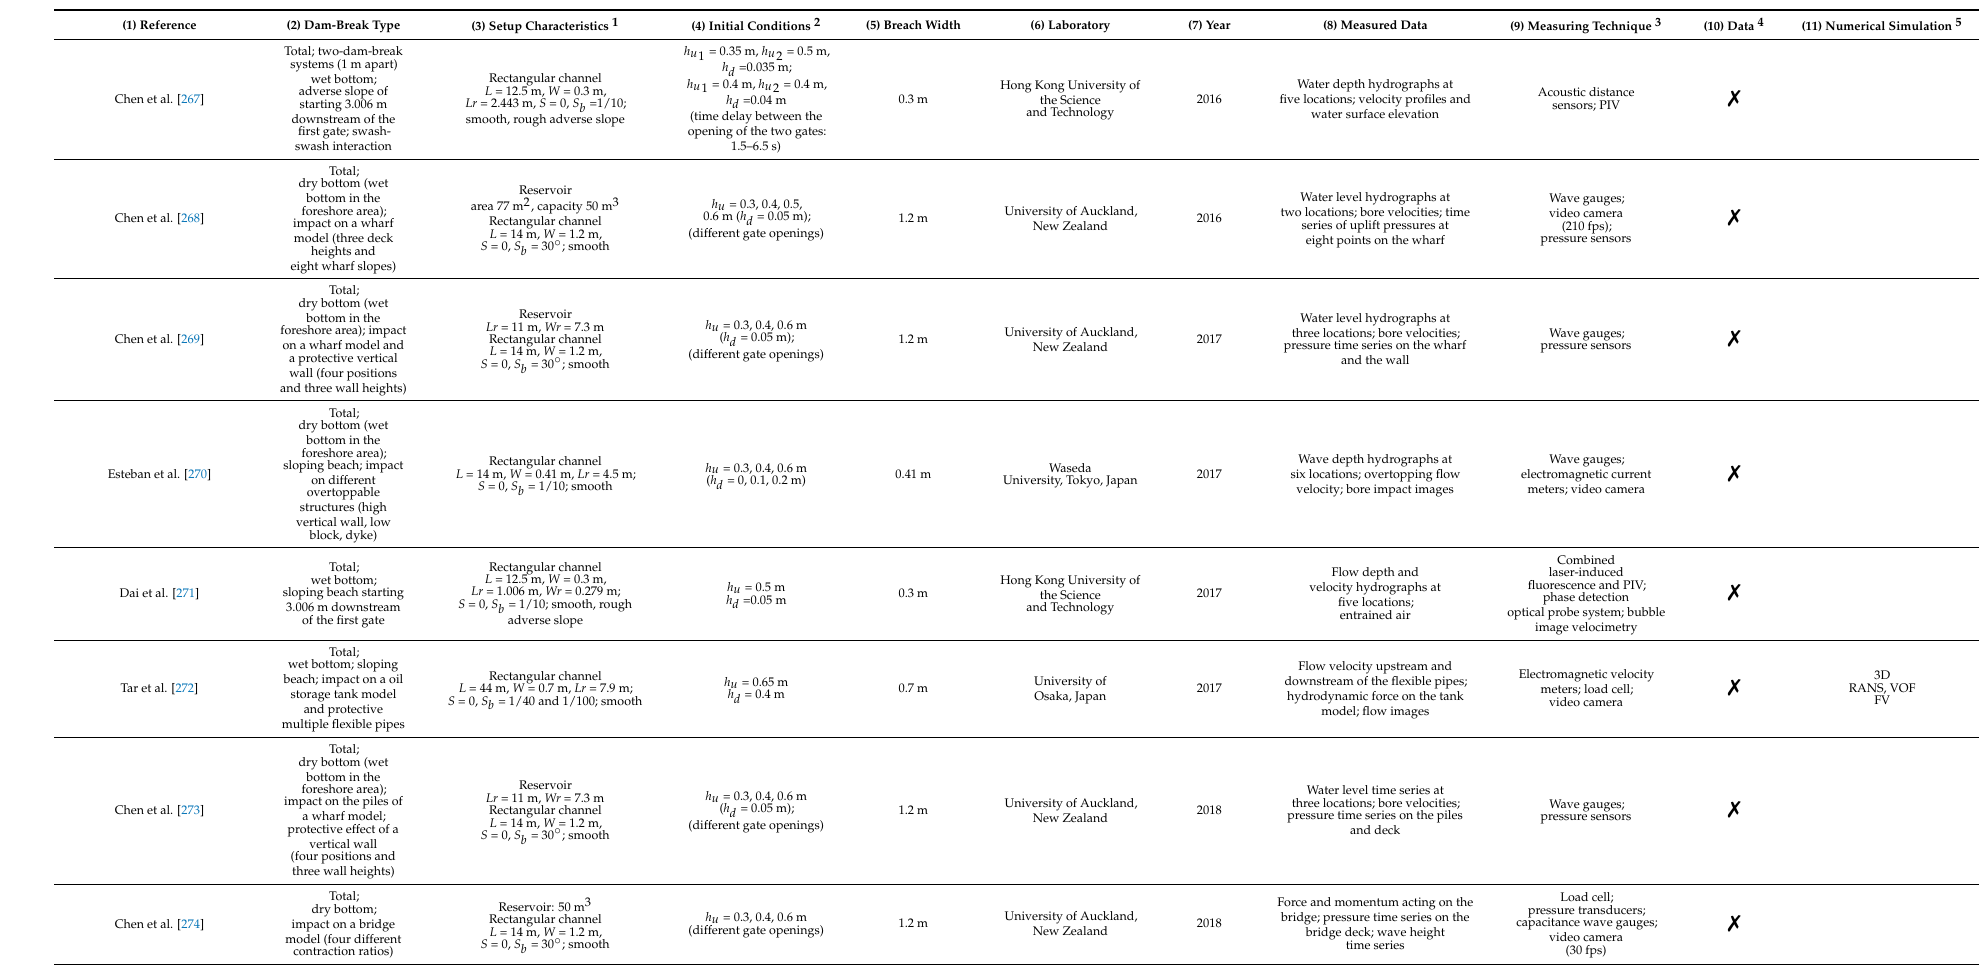
Table 1. Basic experimental investigations of fundamental dam-break wave physical characteristics.